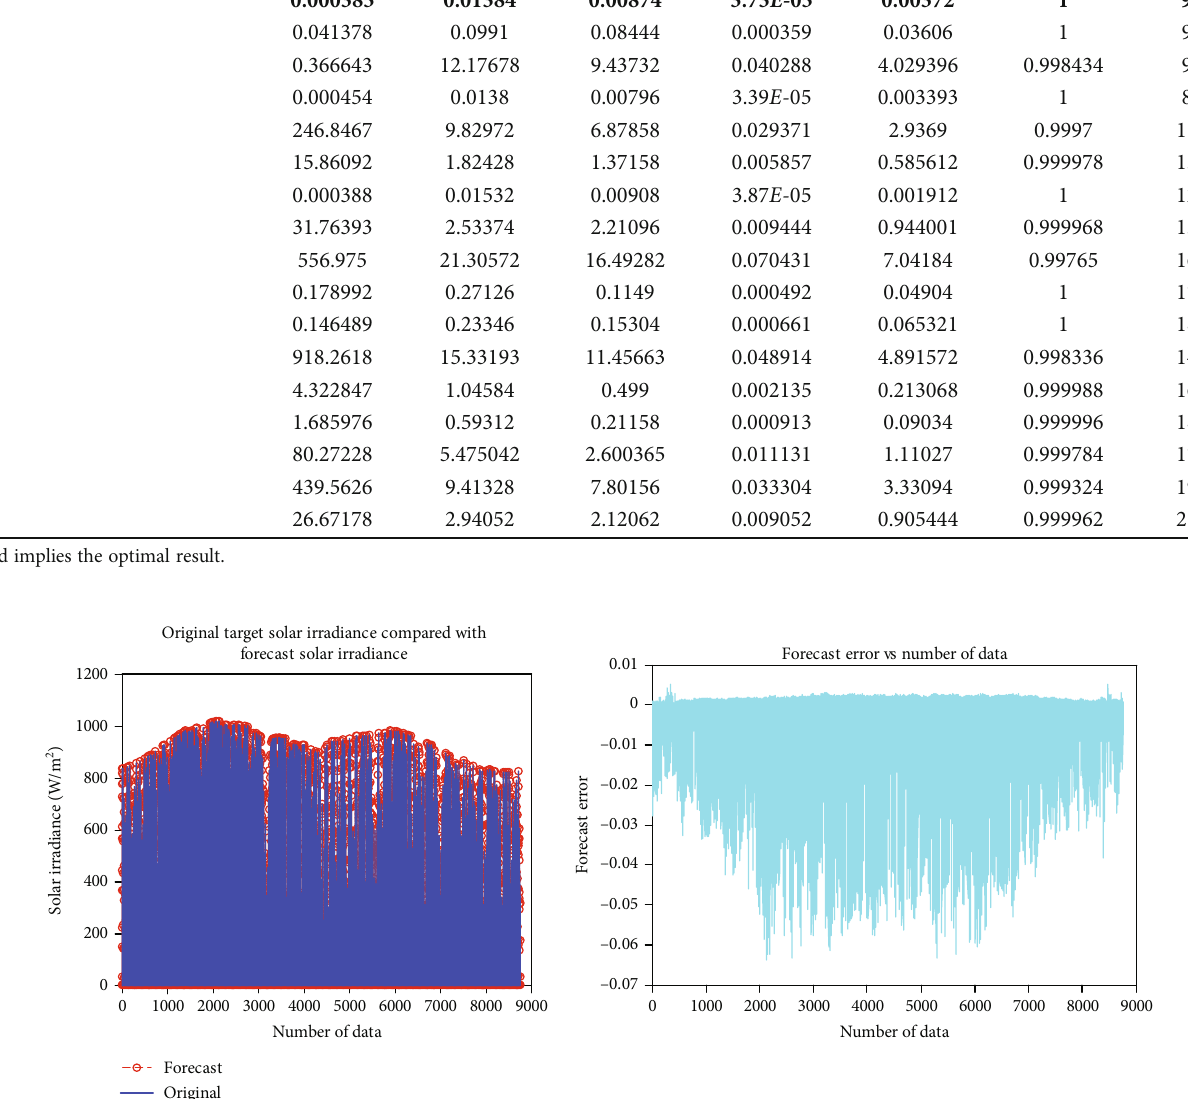
CMMLPNN-based forecasting model simulation time vs. a number of hidden neurons is irregular because hidden neu- rons impact errors and computational time, which can be understood from Figure 22. The proposed model ’ s e ff ective- ness is demonstrated with the experimental simulation results, which implies that the proposed model achieves improved generalization with more stable and accurate outputs.